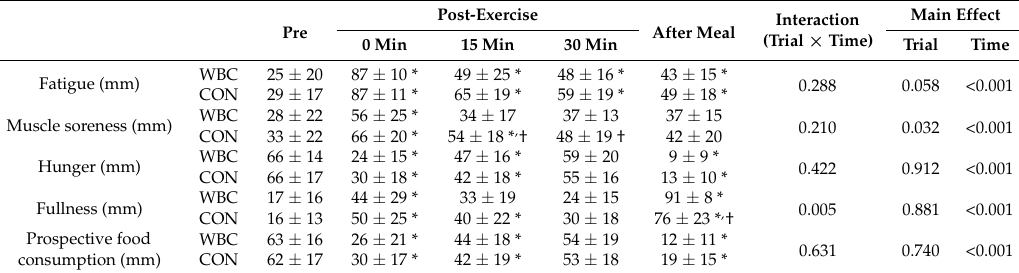
Table 1. Score of subjective feeling of fatigue, muscle soreness and appetite.